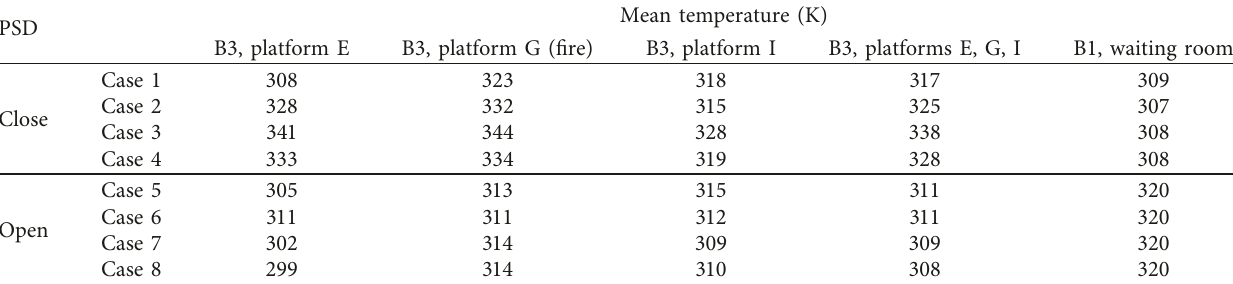
Table 2: Temperature distribution of the underground subway station.